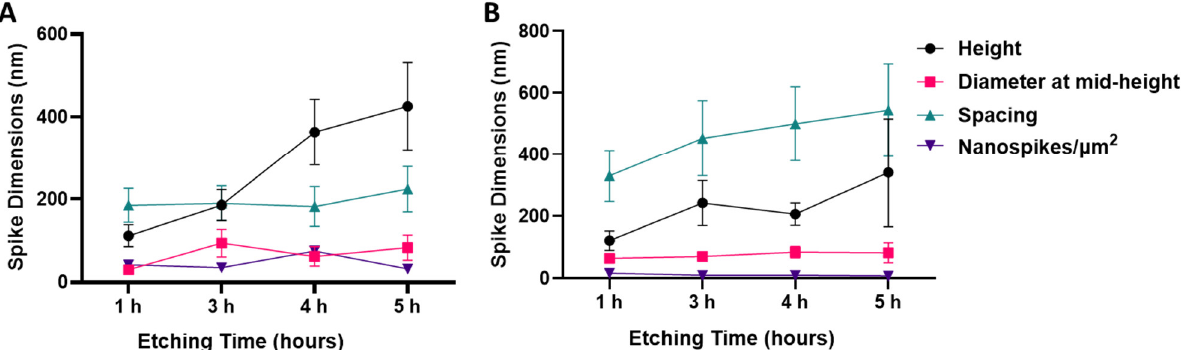
Figure 2. Nanostructures’ dimensions for NaOH-etched samples ( A ) and KOH-etched titanium samples ( B ) measured from four etching times (1, 3, 4, and 5 h). Mean ± SD. Details of nanostructures height, diameter at mid-height, spacing and density can be found in Table S1.